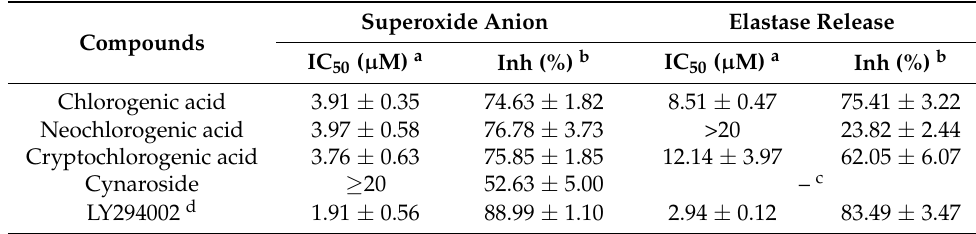
Table 1. The effect of compounds from Lonicerae japonicae flos (LJ) on superoxide anion generation and elastase release in fMLF/CB-induced human neutrophils.